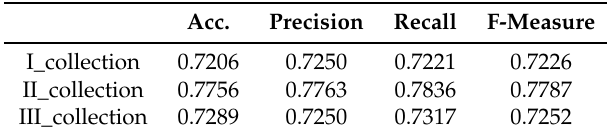
Table 6. The results of sentiment classification with the aid of vectors obtained by using Word2Vec as